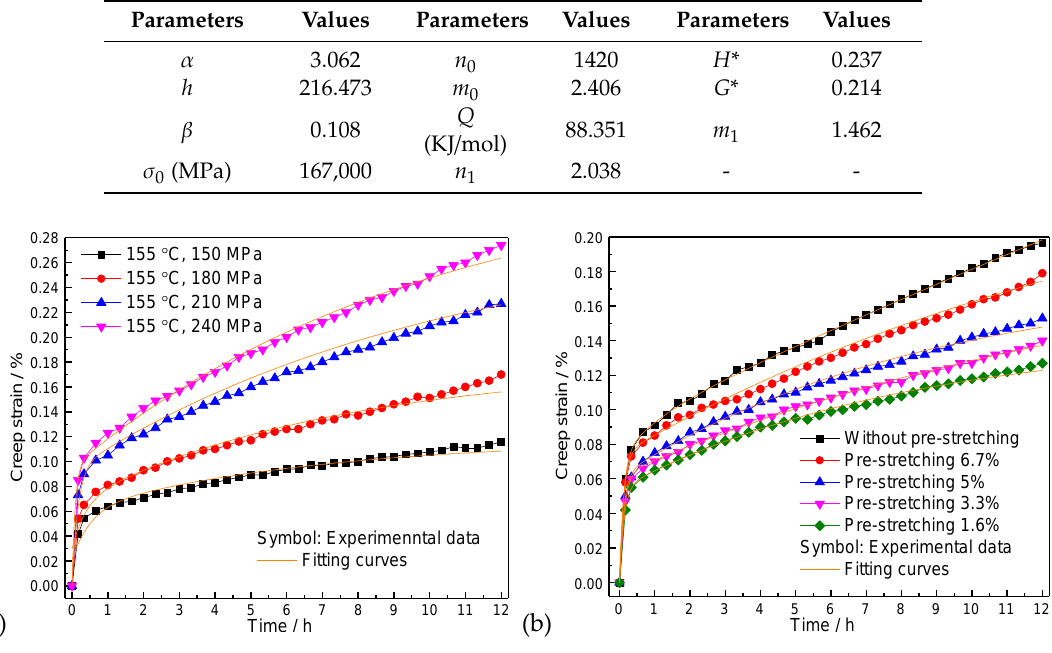
-0.11602 0.00456